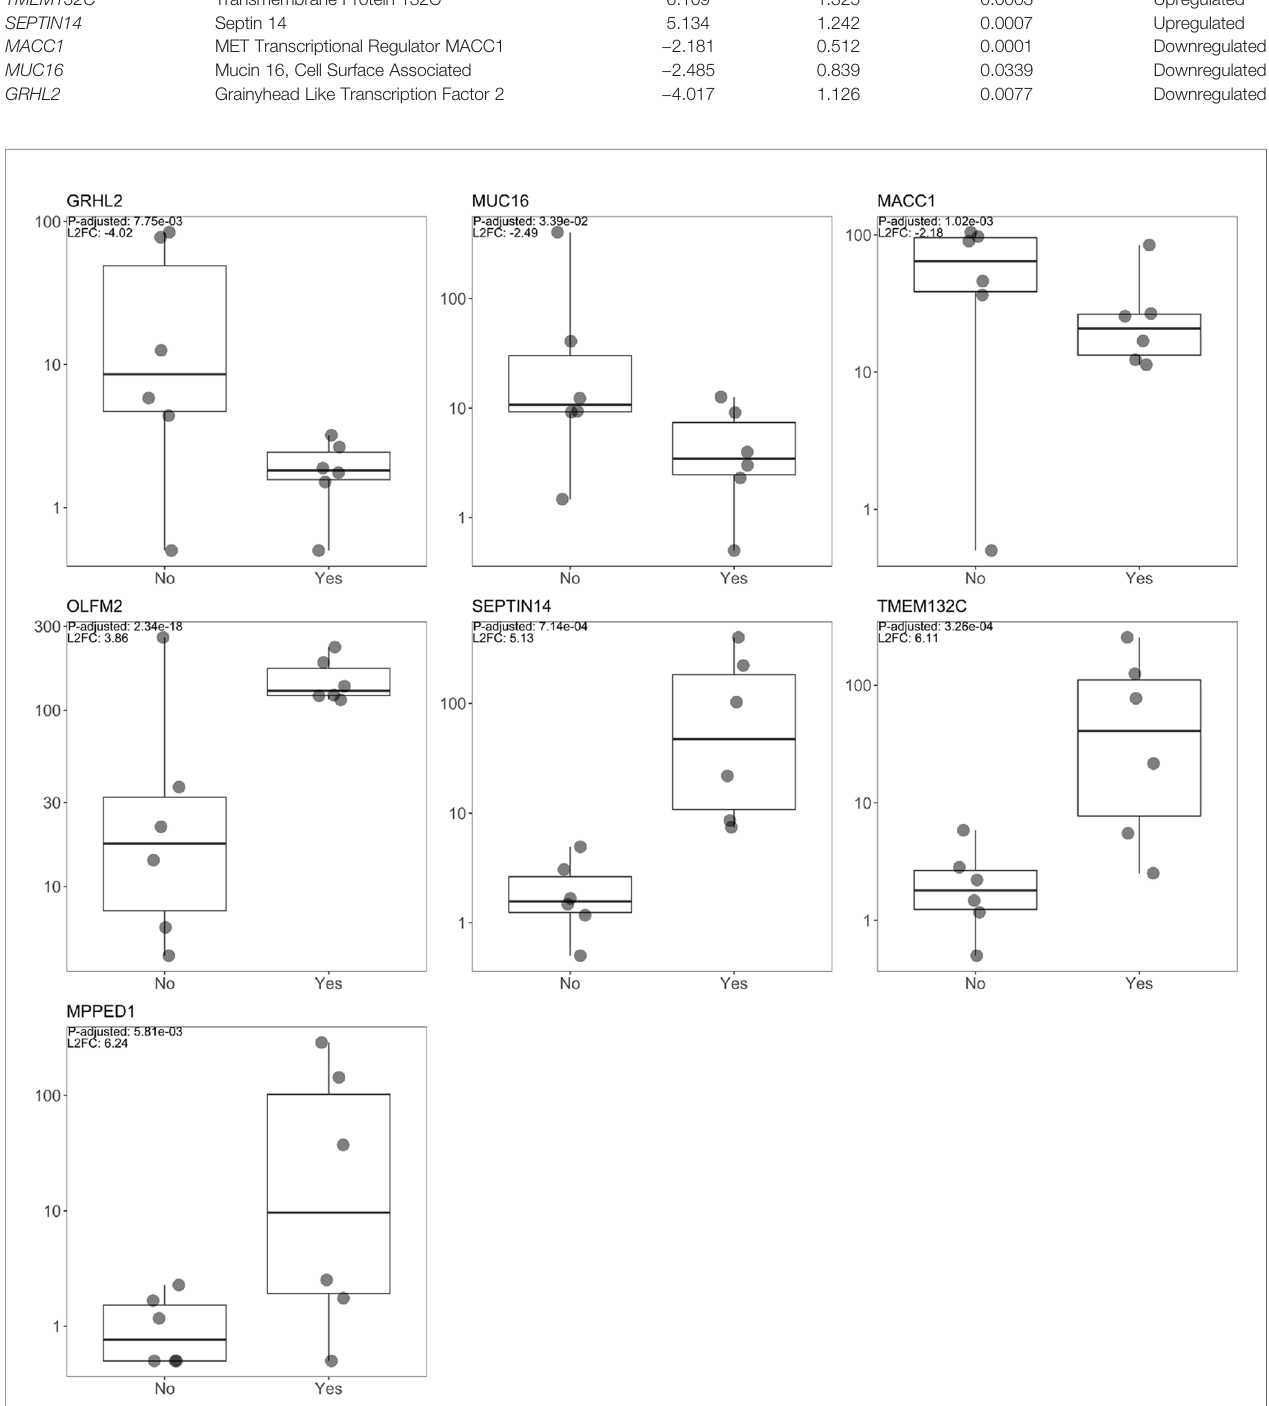
FIGURE 2 | Box plot diagrams displaying raw read count distribution at the log10 scale for both the SSA/DA treated and untreated groups for the seven DEGs ( OLFM2 , MACC1, GRHL2, MUC16, TMEM132C, SEPTIN14, MPPED1 ), with the top L 2 FC positive and negative changes and for DEGs with the lowest FDR value ( OLFM2 ).